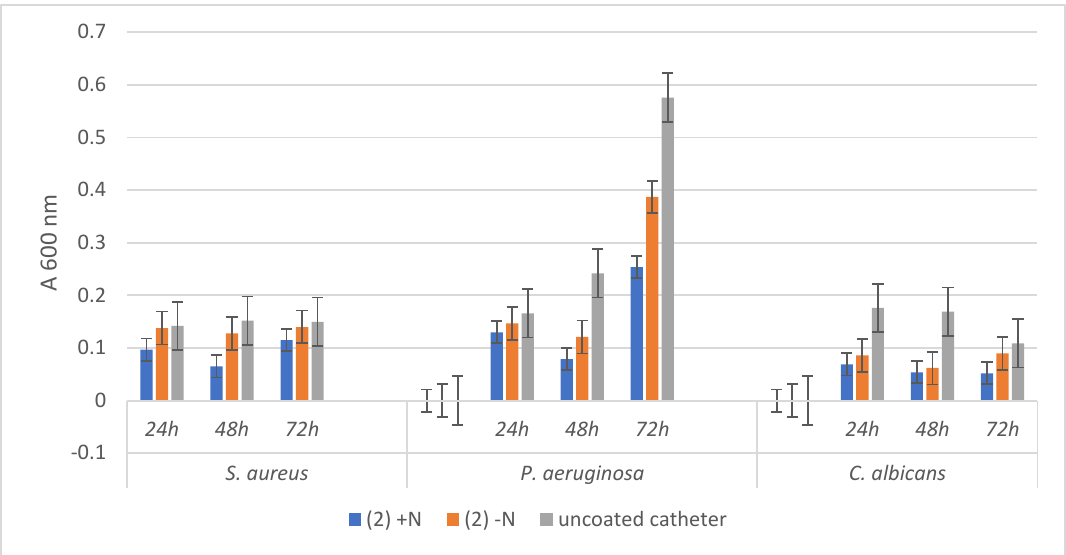
Figure 7. Absorbance values of the three tested microbial strains growth dynamics in the presence of uncoated catheter samples and respectively coated with the hybrid nanostructure ( 2 ) + N and the free compound ( 2 ) −